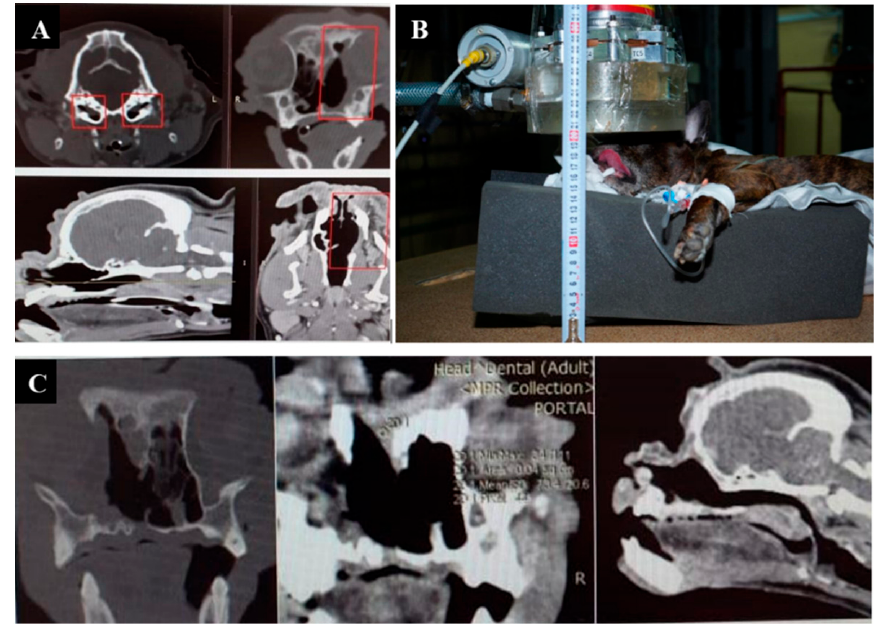
Figure 1. A dog named “Daya”. ( A )—CT of the head before irradiation. ( B )—positioning of the animal during the irradiation session. ( C )—CT of the head 3 months after irradiation. Daya is alive as of 7 January 2022, with no signs of negative dynamics. According to a CT scan of the lungs, the metastases have decreased in size. No tumor tissue is visible in the nasal